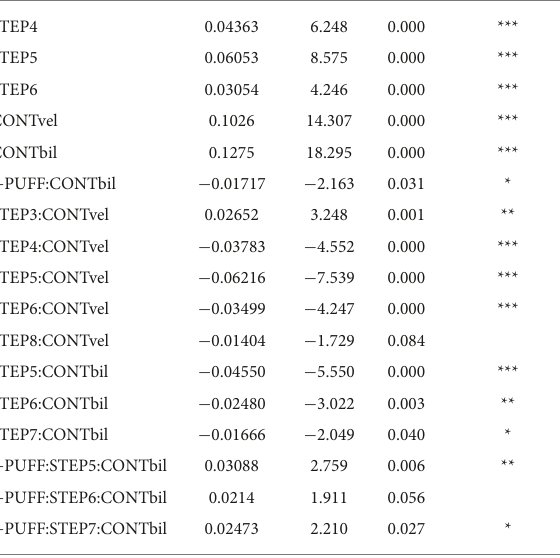
TABLE 6 Output of LMM predicting log 10 response times from PUFF, CONTinuum, and stimulus STEP along the